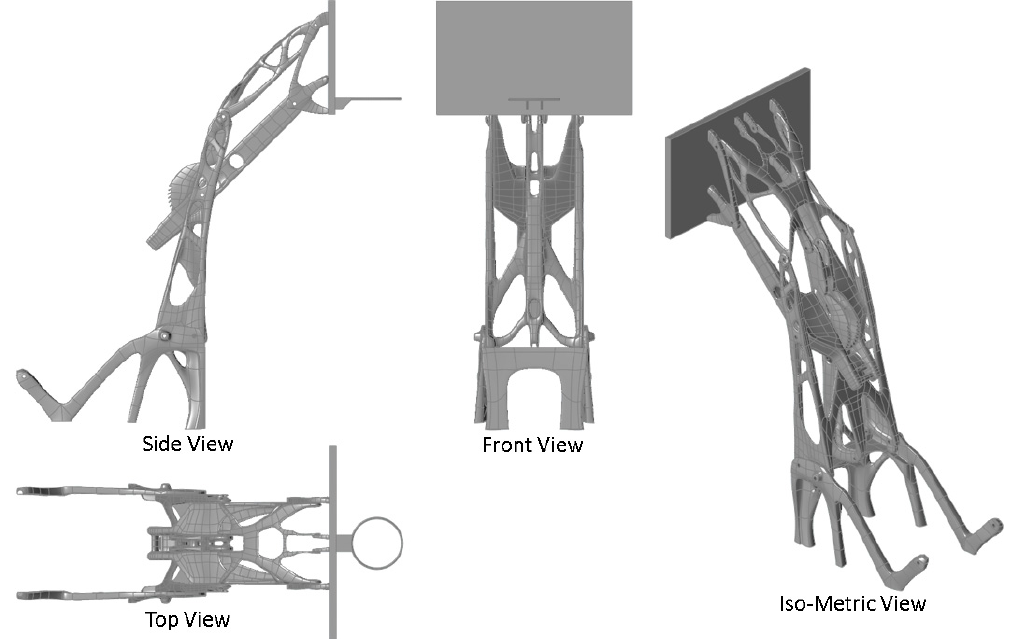
Figure 5. Topology interpretation of optimization